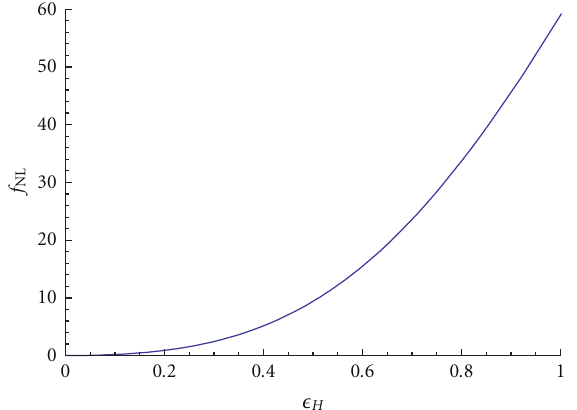
Figure 1: Plot showing f NL as a function of (cid:2) H towards the end of inflation, for the values of the parameters given in the text. Inflation ends when (cid:2) H = 1; for this example f NL (cid:11) 59 at that